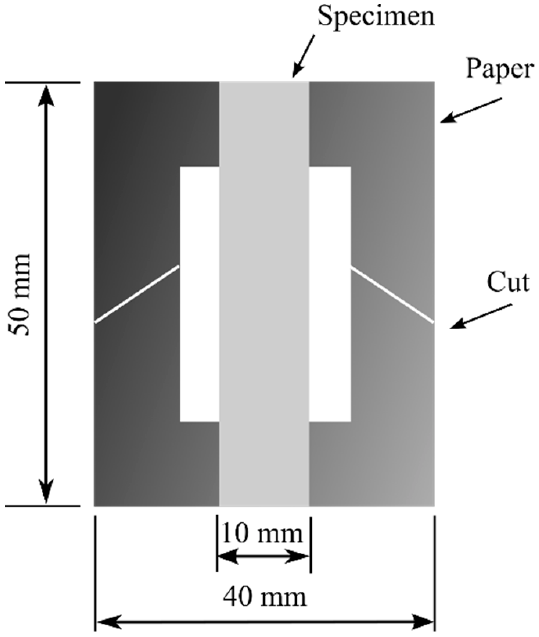
Figure 2. Specimen with piece of paper.